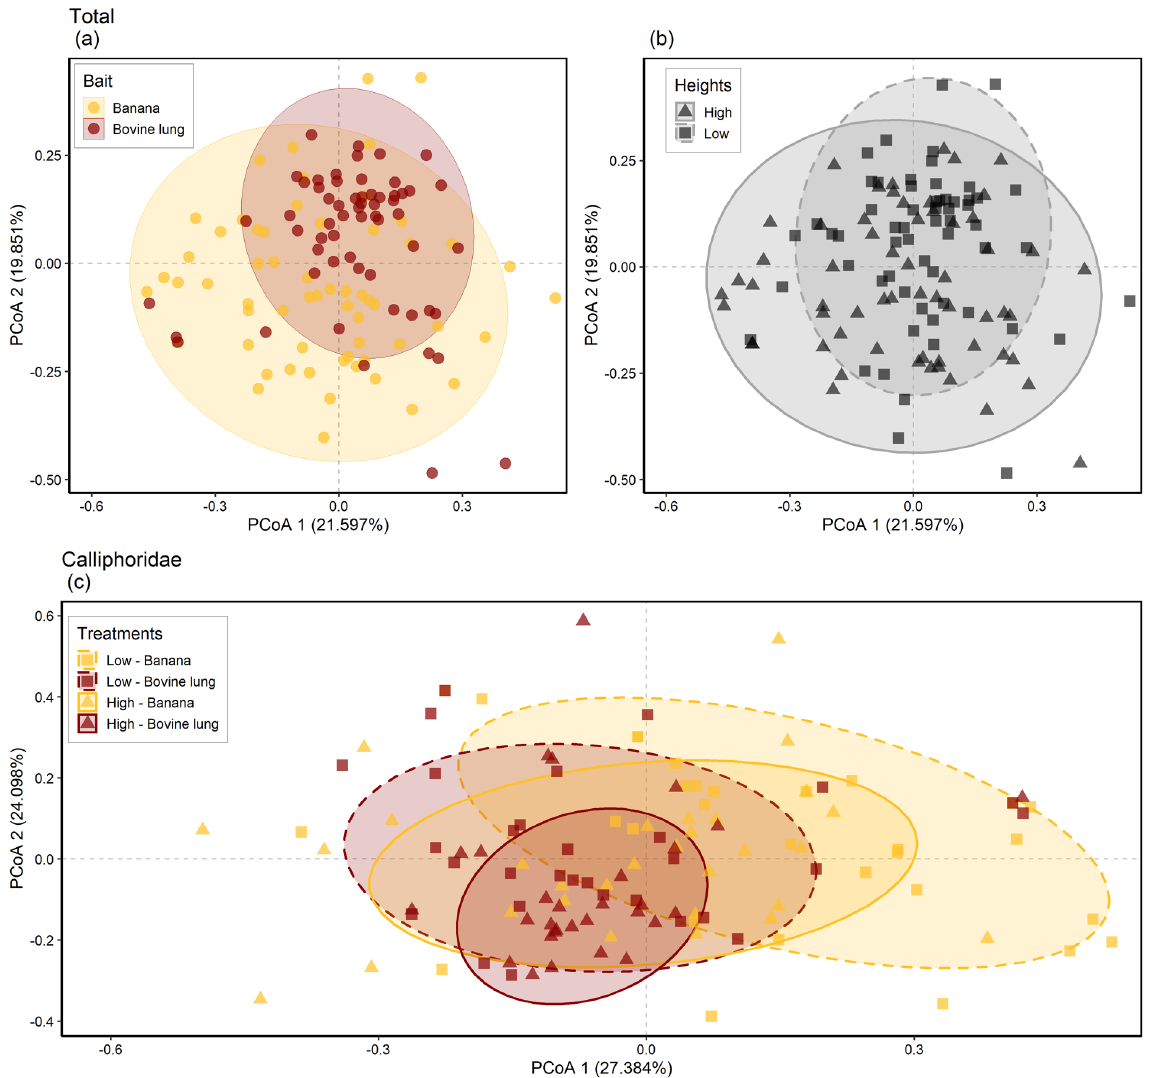
Figure 4. Principal Coordinate Analysis (PCoA) of the composition Total flies Calliphoridae and Mesembrinellidae collected in (a) two baits (banana and bovine lung) and (b) two heights (high and low); and Analysis of the Main Coordinates (PCoA) of the composition only of the flies Calliphoridae (c) showing interaction between the four treatments (high banana, high lung, low banana, low lung) collected in the forest in Mazagão, State of Amapá,